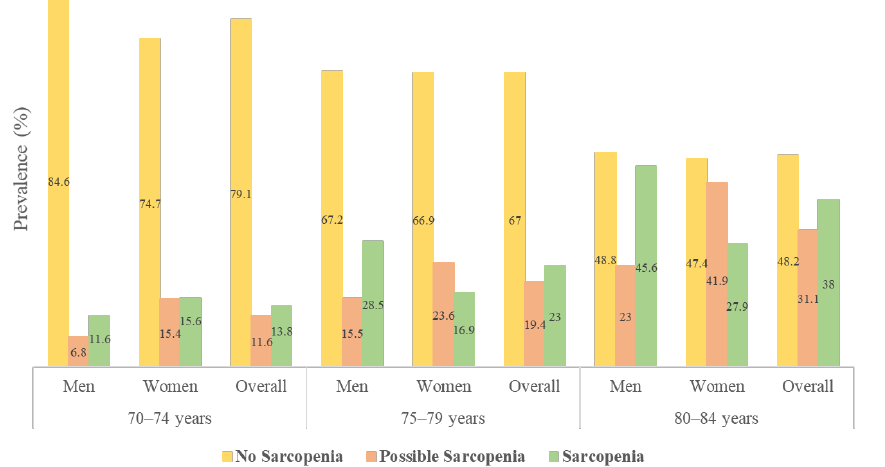
Figure 1. Prevalence (%) of no sarcopenia, possible sarcopenia, and sarcopenia. The prevalence of possible sarcopenia and sarcopenia, as defined by the Asian Working Group for Sarcopenia 2019, was significantly different between men and women ( p < 0.001). Possible sarcopenia was defined